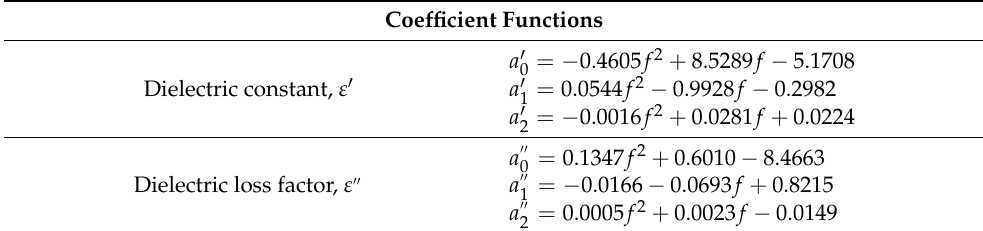
Table 1. Quadratic coefficients of Equations (15) and (16). Coefficient